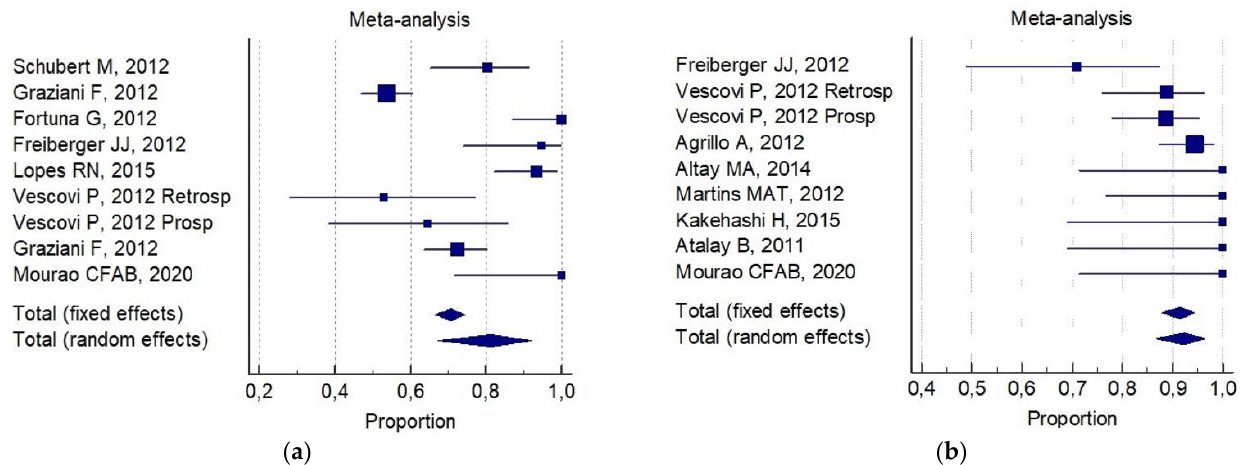
Figure 2. Forest plot results of pooled results about complete resolution in ( a ) invasive (conservative/aggressive) treatments, and ( b ) invasive (conservative/aggressive) treatments + non-invasive treatments.